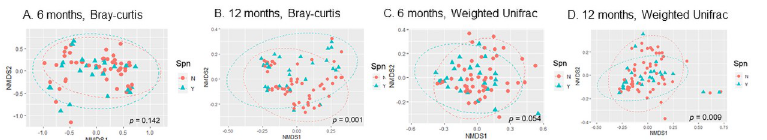
Fig 2. Difference in beta diversity of microbiome between Spn+ and Spn- NP samples in children at 12 months. Bray-Curtis distance (A and B) or weighted unifrac (C and D) of samples collected at 6 months or 12 months were measured and visualized on NMDS plots. Permanova was performed for samples stratified by age to assess the difference between Spn+ and Spn- samples. The p values are shown at the right bottom corner of each plot.